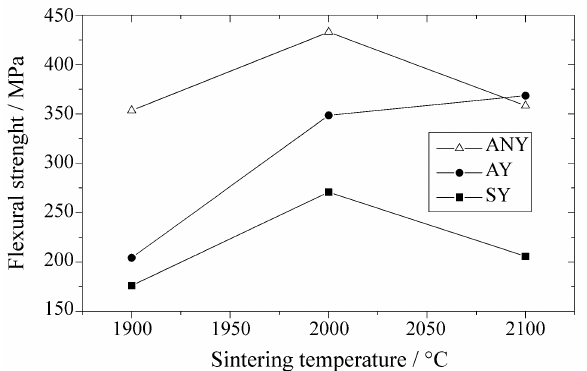
Figure 5. Flexural strength of the samples vs. sintering temperature.